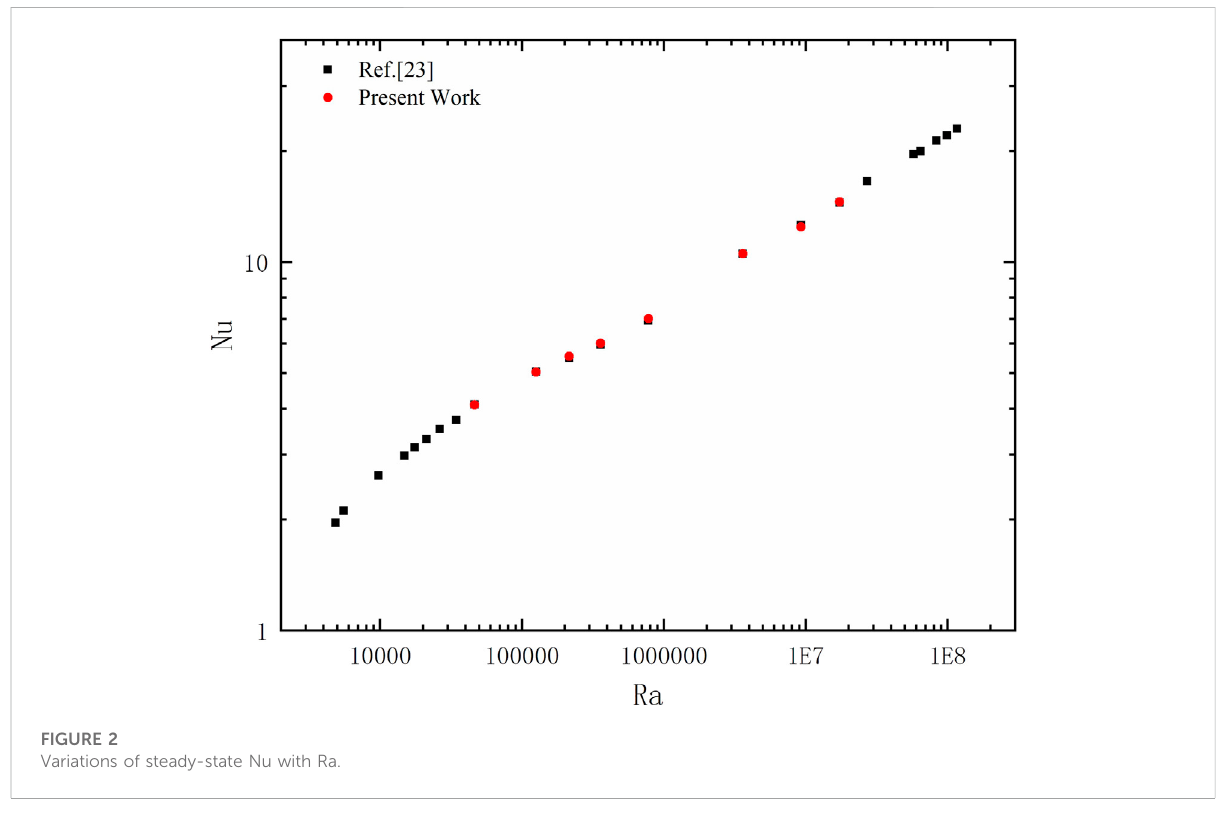
FIGURE 2 Variations of steady-state Nu with